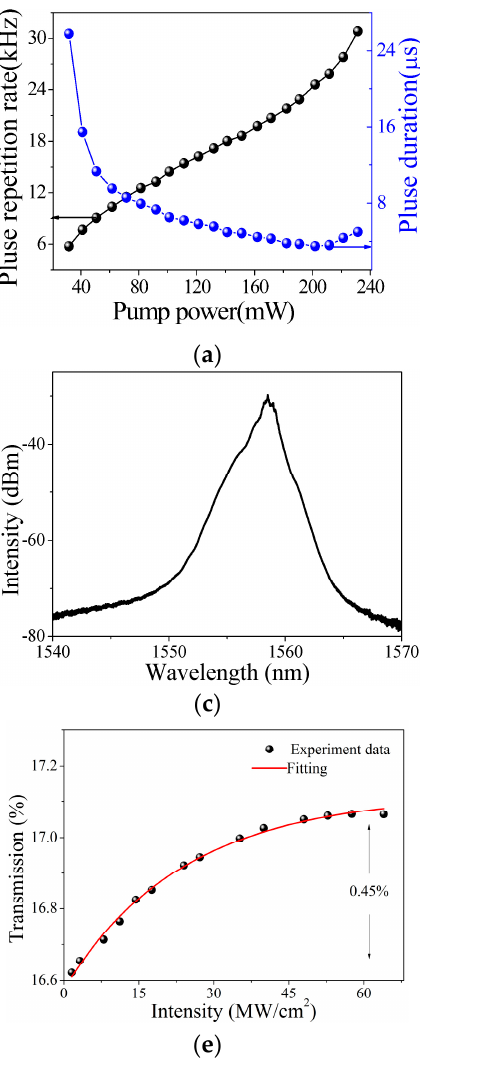
Figure 6. ( a ) Repetition rate, pulse duration as well as ( b ) average output power, single-pulse energy of Q-switched pulses at different pump powers; ( c ) optical spectrum and ( d ) pulse train of the Q-switched laser using the BP–PI film after stored for six months; ( e ) saturable absorption property of the film; ( f ) stability of the BP–PI film and the BP–PVA film versus the laser operation time.